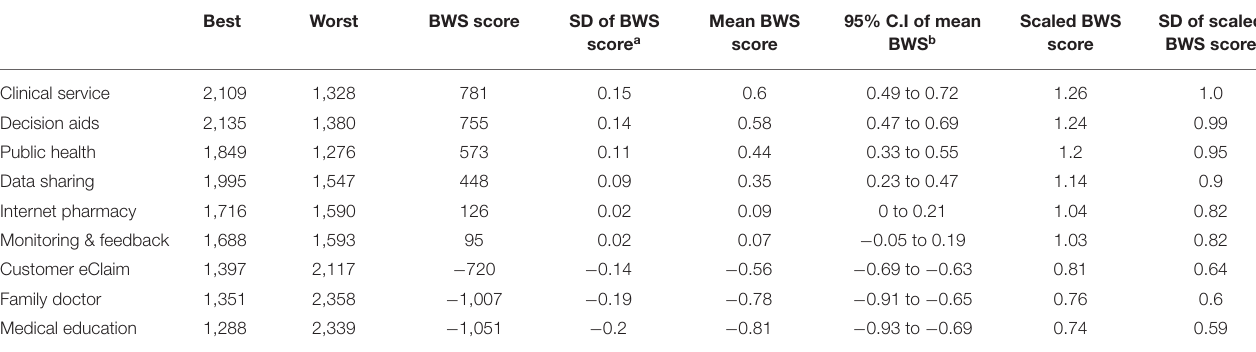
TABLE 4 | The results of the BWS survey. Best Worst BWS score SD of BWS